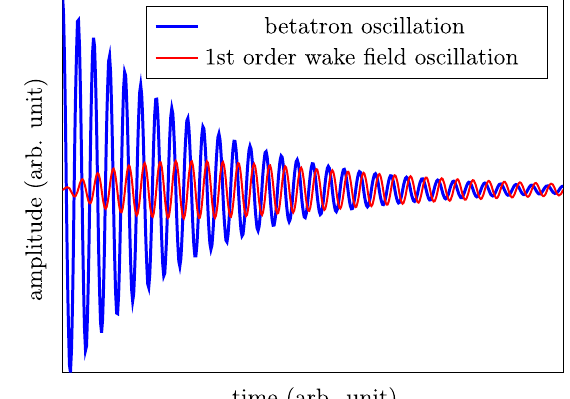
FIG. 1. Illustration of the betatron damping oscillation and the first order wakefield